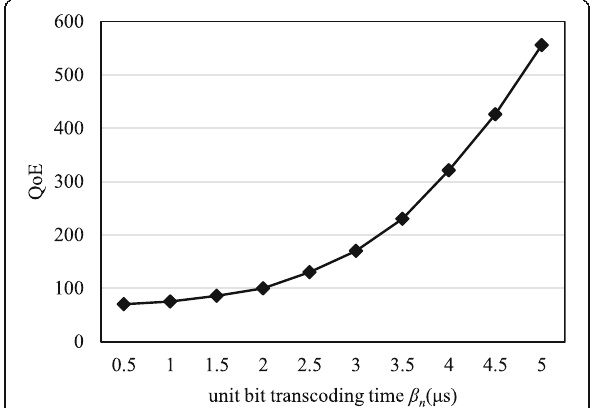
Fig. 6 QoE function changes with the unit bit transcoding time β